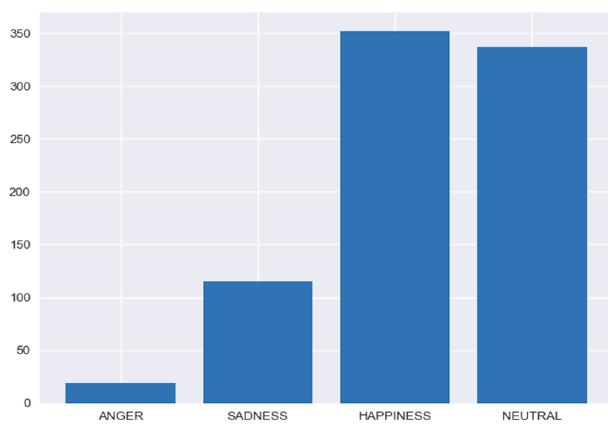
Figure 4. Data displayed to the ergonomist; each bar represents the number of times an emotional event has been recorded, and the figure is updated every 5 seconds.